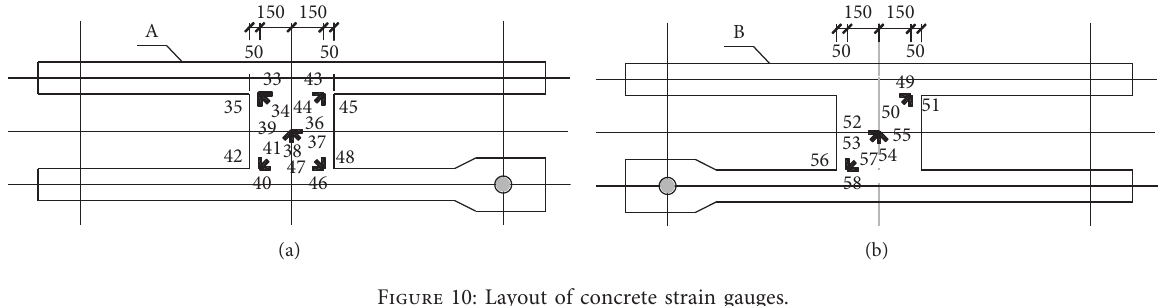
Figure 10: Layout of concrete strain gauges.